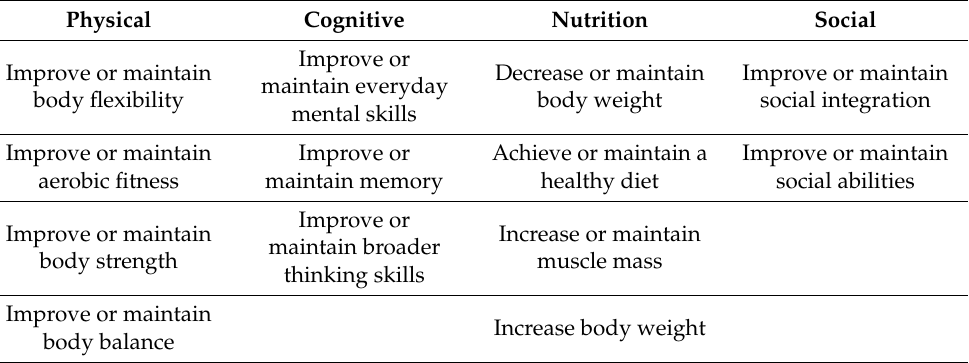
Table 2. List of the preferred pathway to well-being for each domain, from the most popular to the least